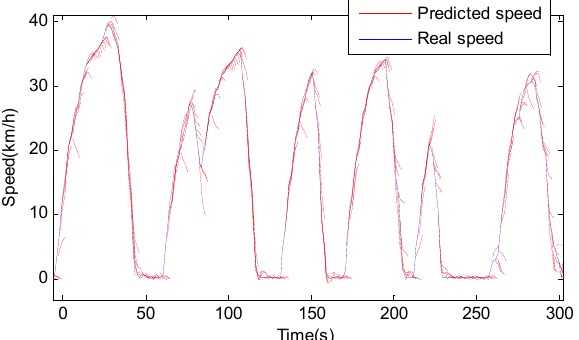
Figure 9. Short-term predicted speed compared with the real speed.